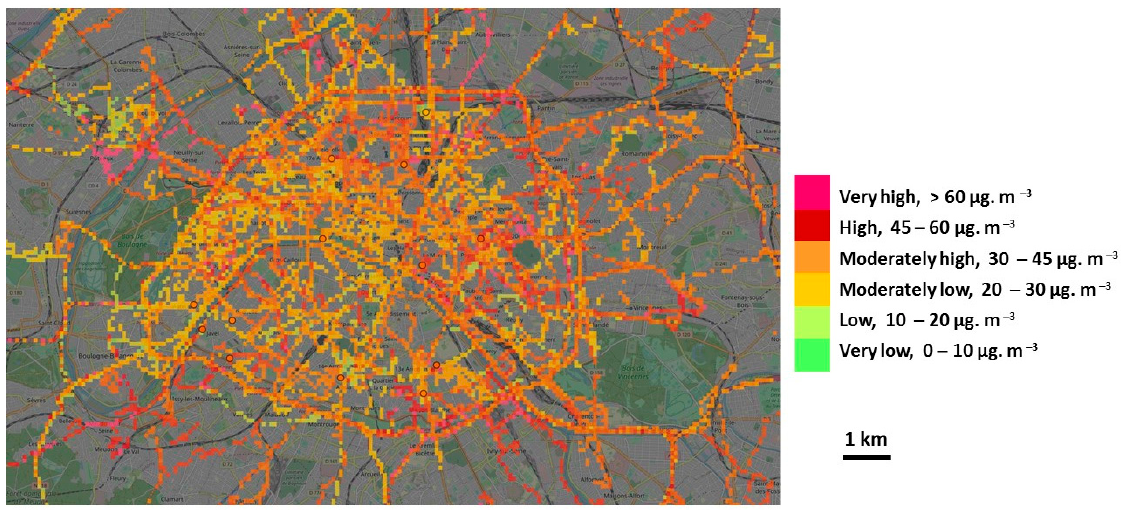
Figure 15. Pollution map in Paris averaged for the 26–28 March 2020. North is up.